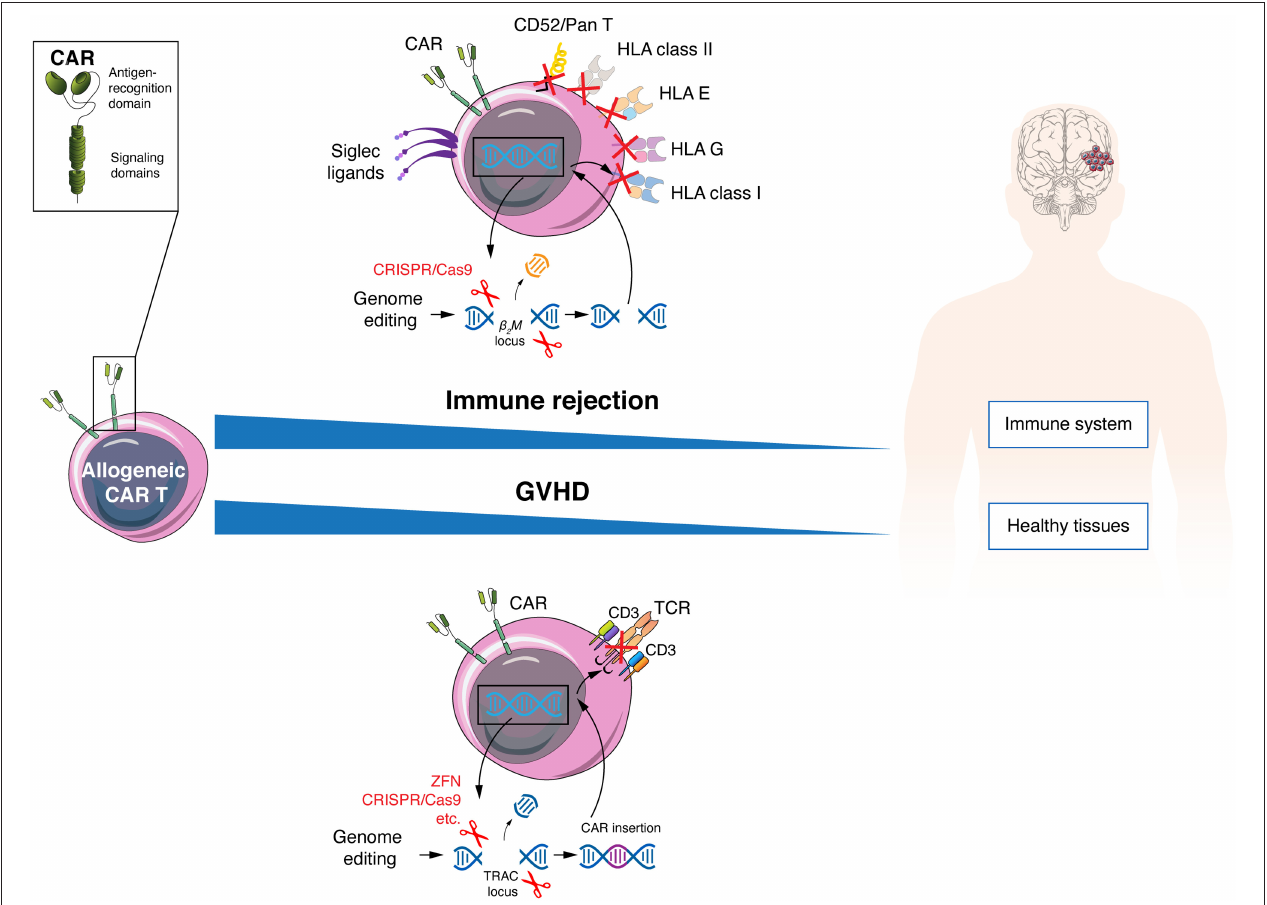
FIGURE 2 | Allogeneic CAR T cells must avoid host immune rejection and GVHD. Allogeneic CAR T cells can evade the patient immune response by genetic disruption of HLA class I and II molecules, resist lymphodepleting regimens using anti-CD52 antibodies by elimination of the CD52 molecule and inhibit NK elimination by increasing expression of Siglec ligands of HLA-E and G variants. To protect patients from GVHD, allogeneic CAR T cells can be engineered to lose TCR